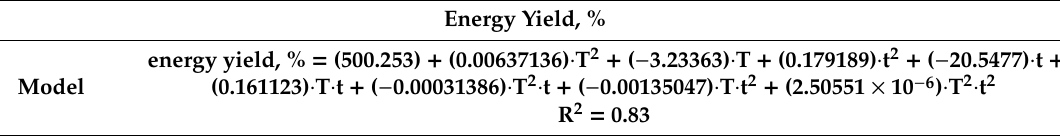
Table A11. The statistical parameters of polynomial regression analysis of the influence of SS torrefaction temperature and residence time on the energy yield of the